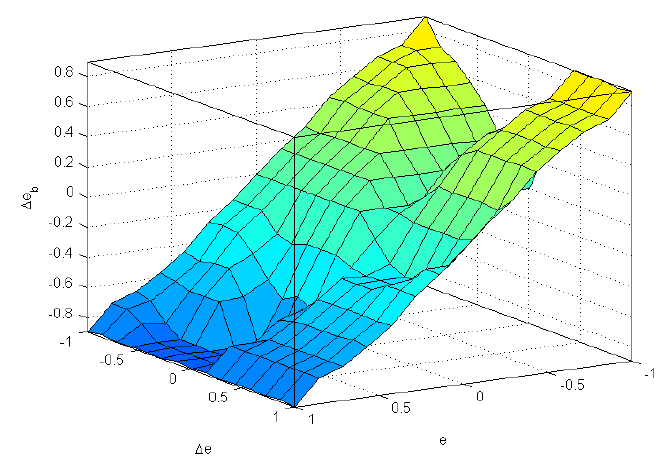
Figure 7. Output variable of fuzzy controller-change in pitch angle ( ∆ e b ).